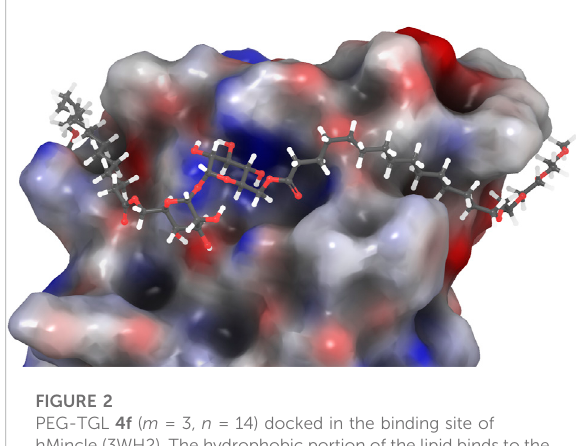
FIGURE 2 PEG-TGL 4f ( m = 3, n = 14) docked in the binding site of hMincle (3WH2). The hydrophobic portion of the lipid binds to the hydrophobic groove of Mincle, while the hydrophilic PEG groups are found outside this binding groove and can increase the water solubility of the ligand (Maestro,